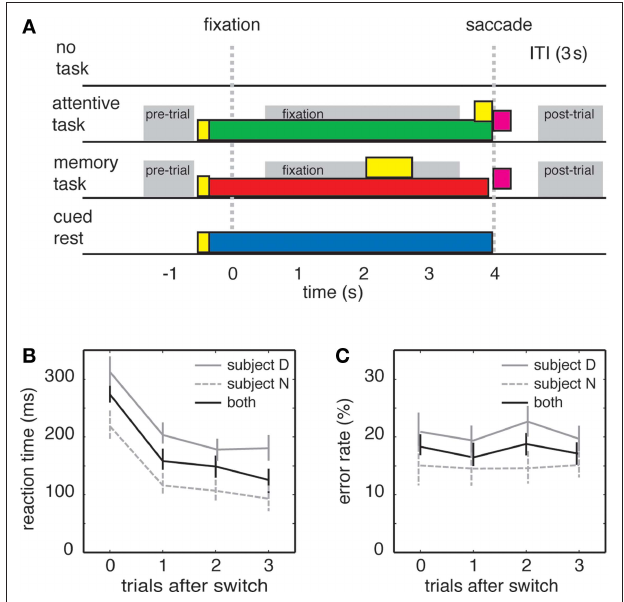
Figure 1 | Task switching influences behavioral performance in rhesus macaques. (A) Schematic of the four tasks; time zero indicates time at which fixation was acquired. In three of the tasks, a yellow small central cue was illuminated (yellow bar). After 200 ms, the cue changed color (green for attentive, red for memory, yellow for cued rest). After shifting gaze toward the spot, the monkey maintained fixation for 4 s (monkey N, shown) or 3 s (monkey D). In the working memory task, an eccentric cue appeared during the delay and remained illuminated for 1 s (yellow bar). Following the fixation period, the cue was extinguished and, in the attentive task, an eccentric target appeared at 1 of 36 locations from a grid surrounding the central cue (yellow square). Monkeys received a reward for shifting gaze to eccentric target or the remembered location (purple squares). Gray bars indicate epochs used for analysis. (B) Plot of reaction times for monkey N (gray-dashed), monkey D (gray), and average for both subjects (black). Bars indicate standard error. (C) Error rates of monkey N (gray-dashed), monkey D (gray), and average for both subjects (black). Bars indicate one standard